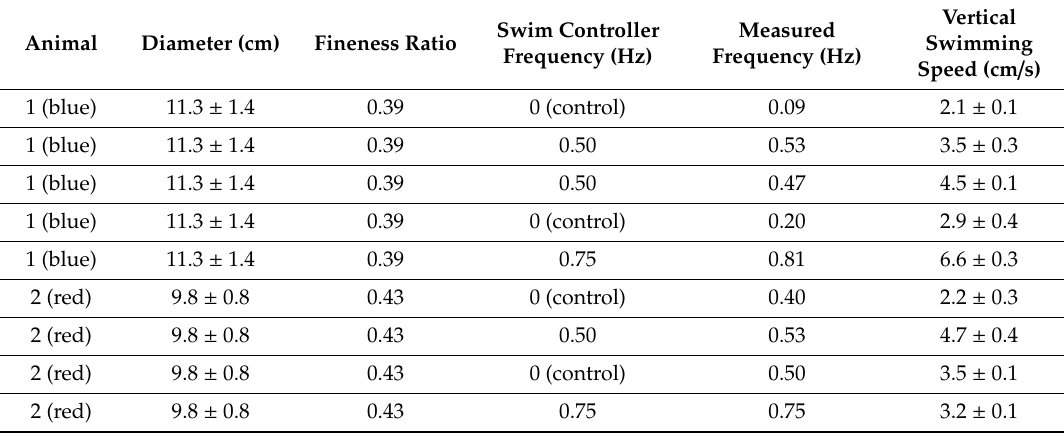
Table A1. Experimental parameters and results for field experiments. The diameter, fineness ratio (defined as the ratio of the bell height to diameter), swim controller frequency, measured frequency from counting animal pulses, and calculated vertical swimming speeds for n = 2 animals (labeled as blue and red to match plot